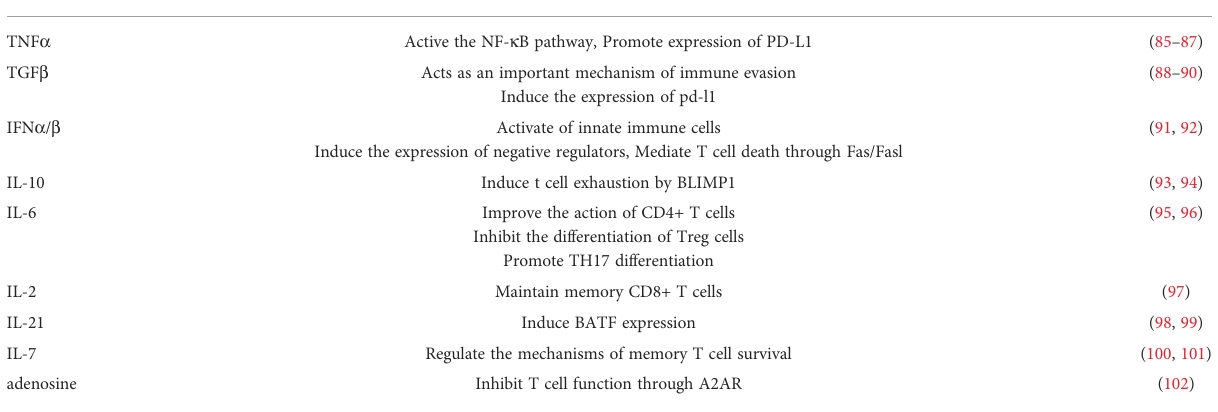
TABLE 1 Factors in chronic in fl